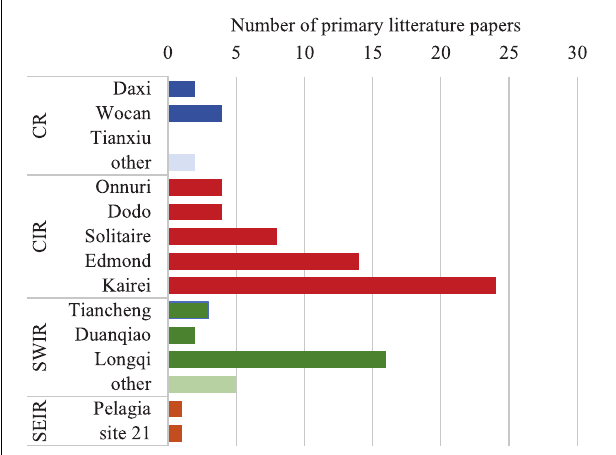
FIGURE 3 | Biological study bias across HTV fields of the Indian mid-ocean ridges. Based on 50 studies cited in this review (full list available as Supplementary Material